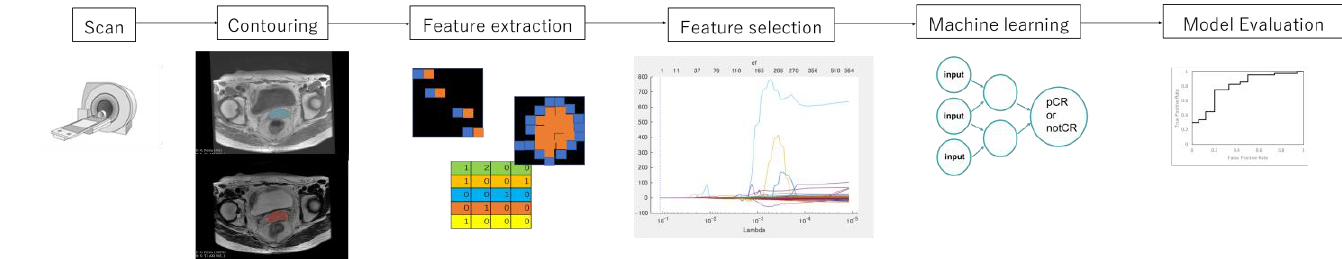
Figure 1. The process of the prediction model with radiomics analysis and machine learning.